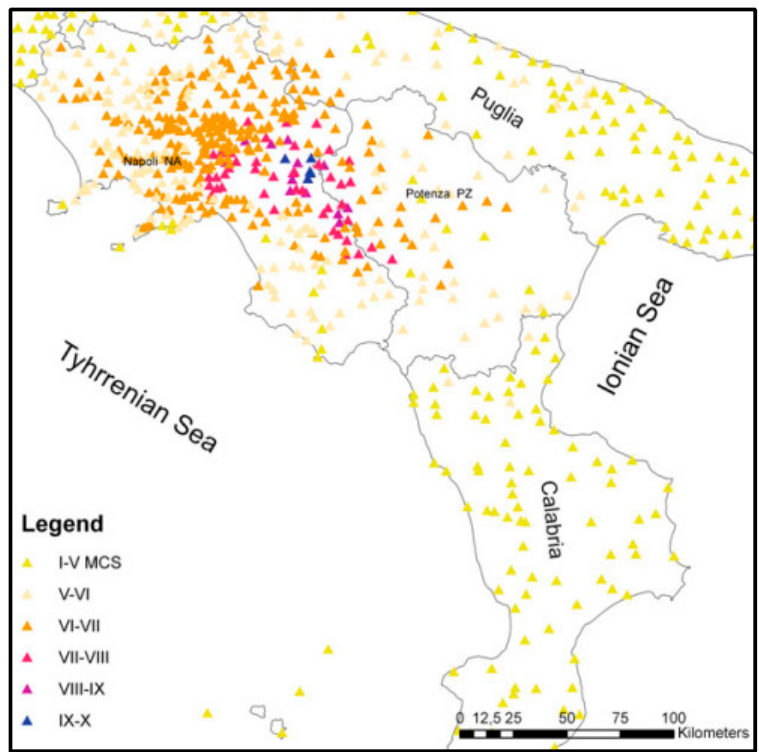
Figure 2. Macroseismic field of the 23 November 1980 Irpinia–Basilicata earthquake [18] (MCS= Mercalli Cancani Sieberg scale).